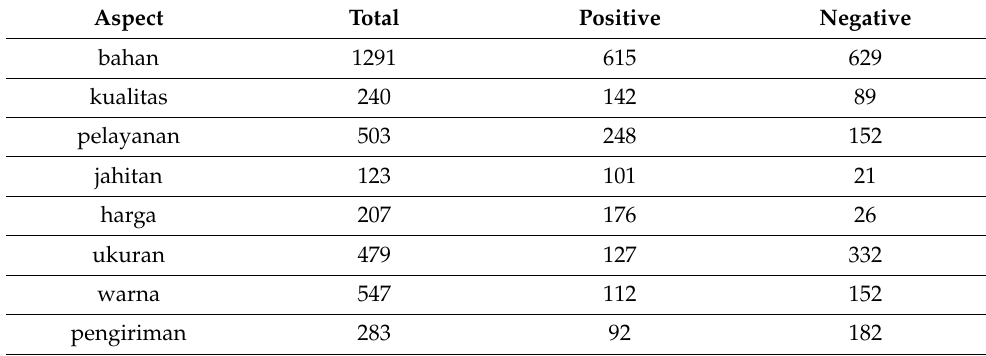
Table 3. The statistics of labeled